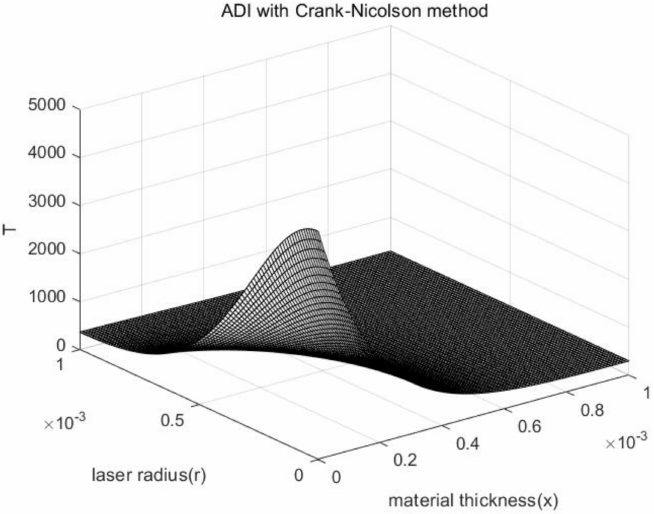
Figure 11. Numerical solutions of difference equations ( h = 0.001 / 100, τ = 0.01 / 500, H = 1.5 ) .